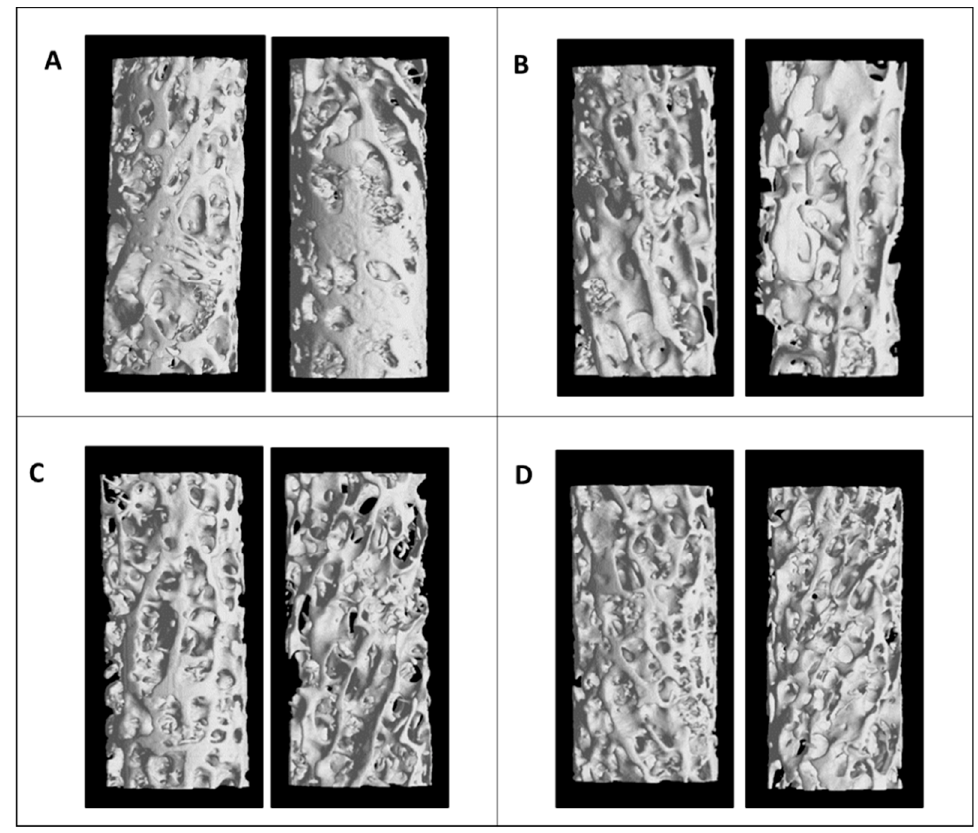
Figure 2. Three-dimensional reconstruction and micro-CT images of bone trabecular from femoral heads in the four groups. Two different samples from: ( A ) OA group; ( B ) OA-T2DM; ( C ) OP; ( D ) OP-T2DM.